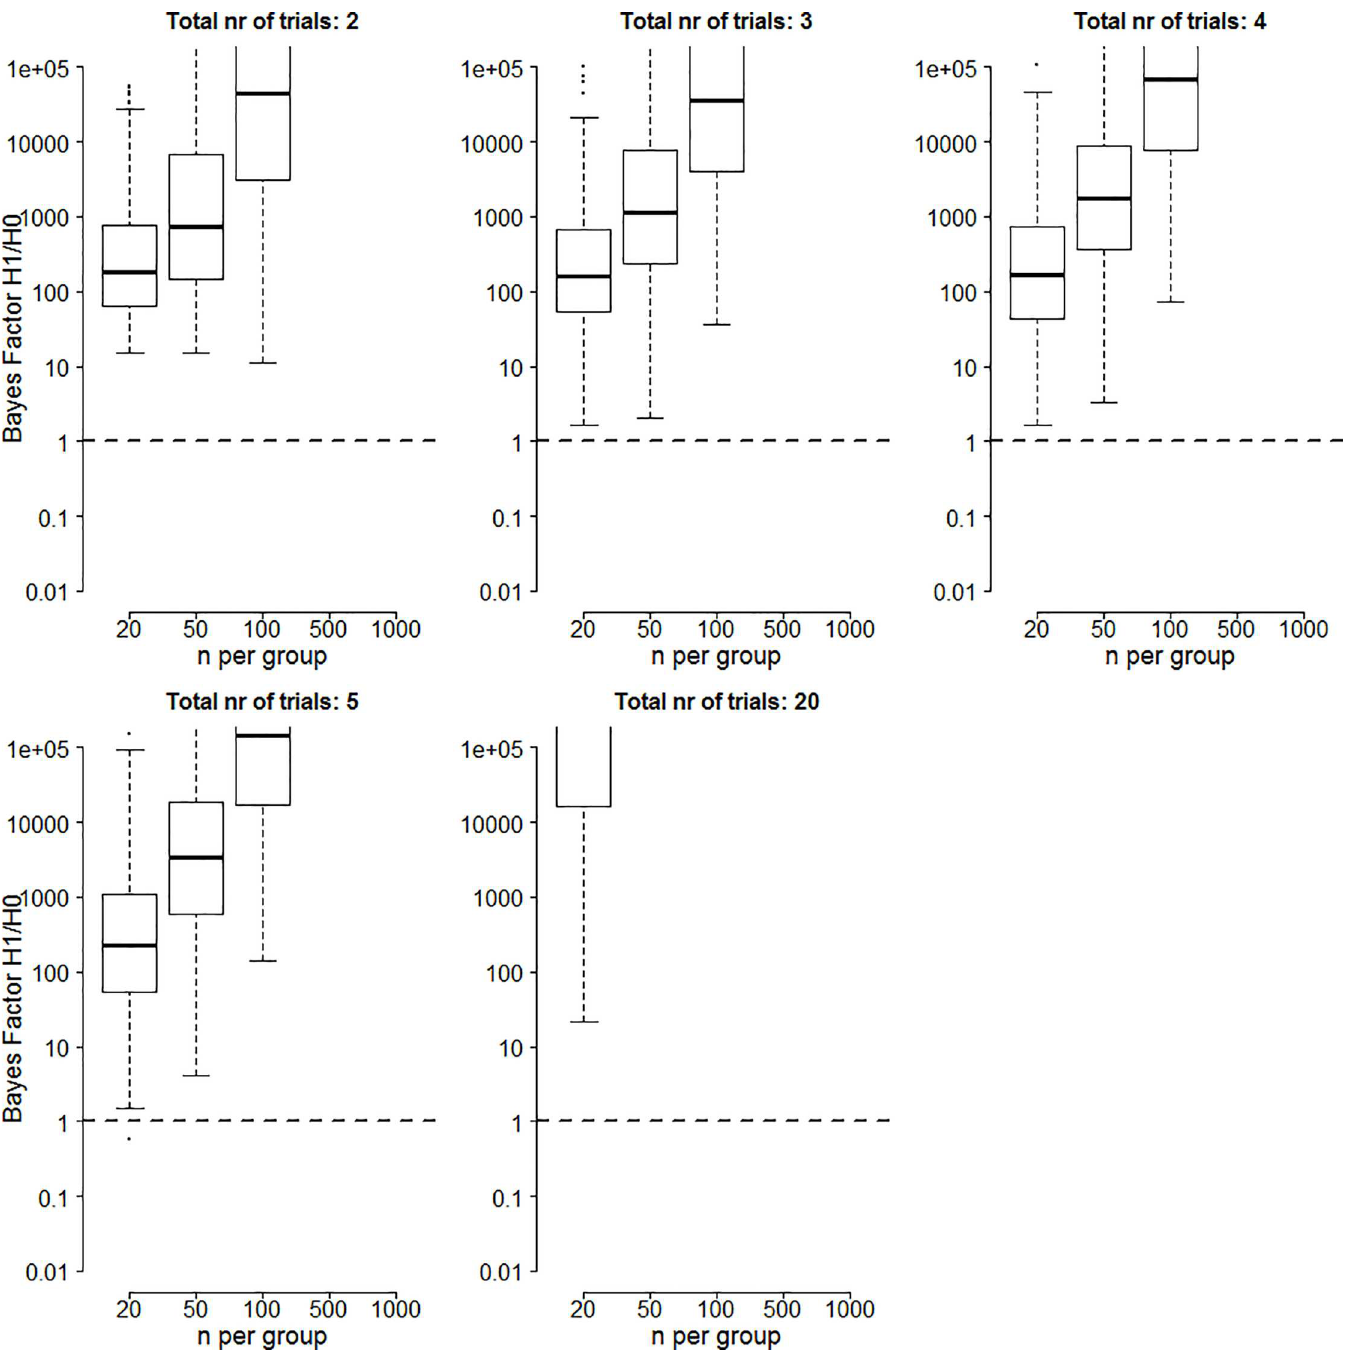
Fig 3. Bayesfactors in favor of the alternative hypothesis for two significant trials when the true effect size is 0.5. Boxes contain Bayes factors for 50% of the simulations with tails extendingto Bayes factors for 100% of the simulations excludingoutliers. Circles indicateoutliers and are those values more than 1.5 * IQRremoved from the